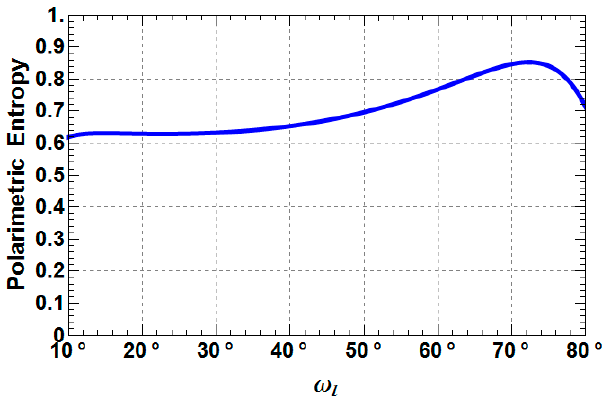
Figure 10. Sensitivity of polarimetric entropy H with local incidence angle ω 1 ( ε s = 20, ε t = 30, L SXD = 1, ϕ = 0°, θ 1 = 30°).